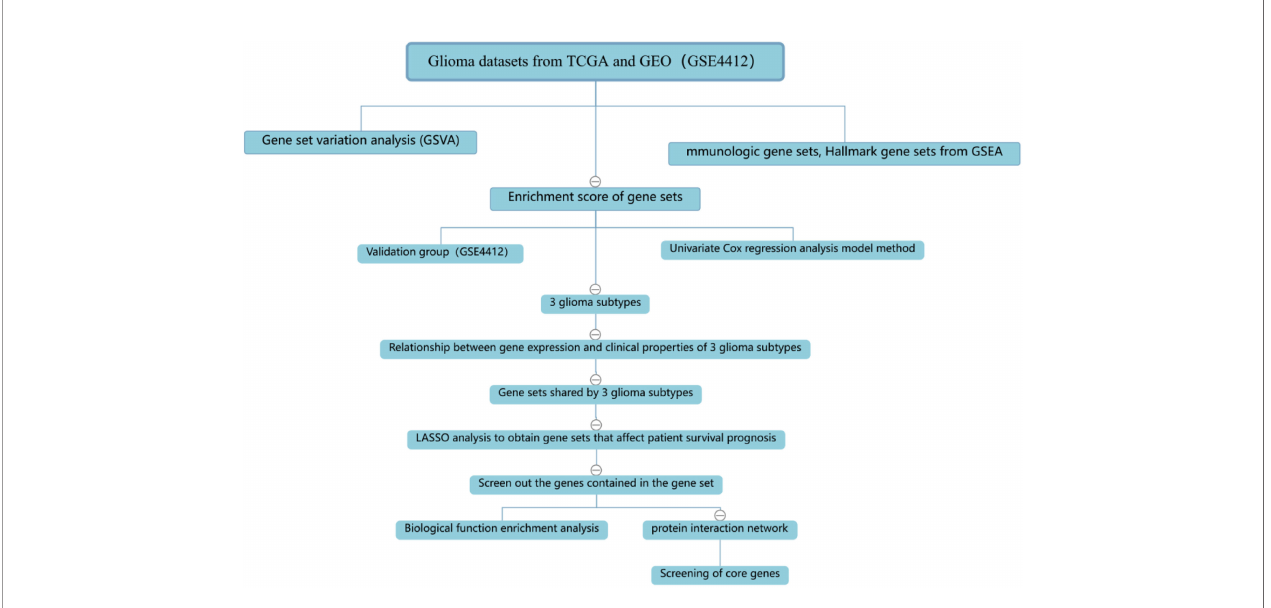
FIGURE 1 | Flowchart about our